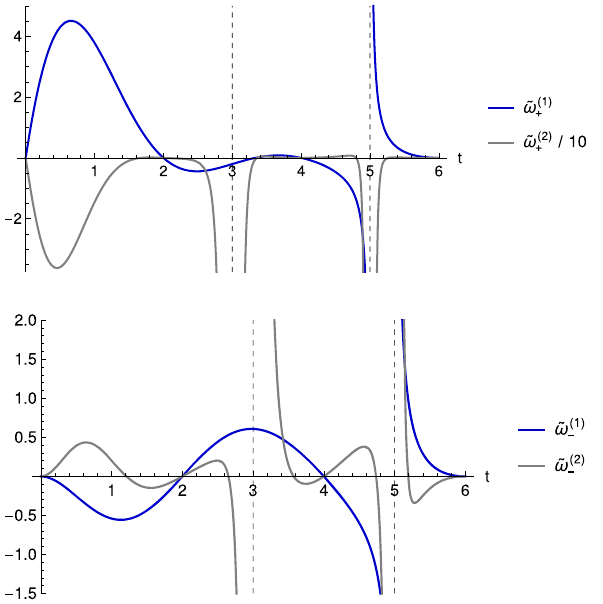
Fig. 2 The first two coefficients of the 1 / N expansion of the criti- cal exponents ˜ ω ± = O ( 1 / N 2 ) coeffiecients can be found in Ref.